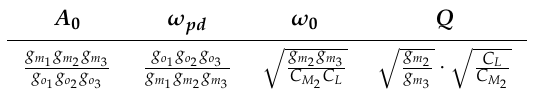
Table 1. Transfer function parameters of the OTA shown in Figure